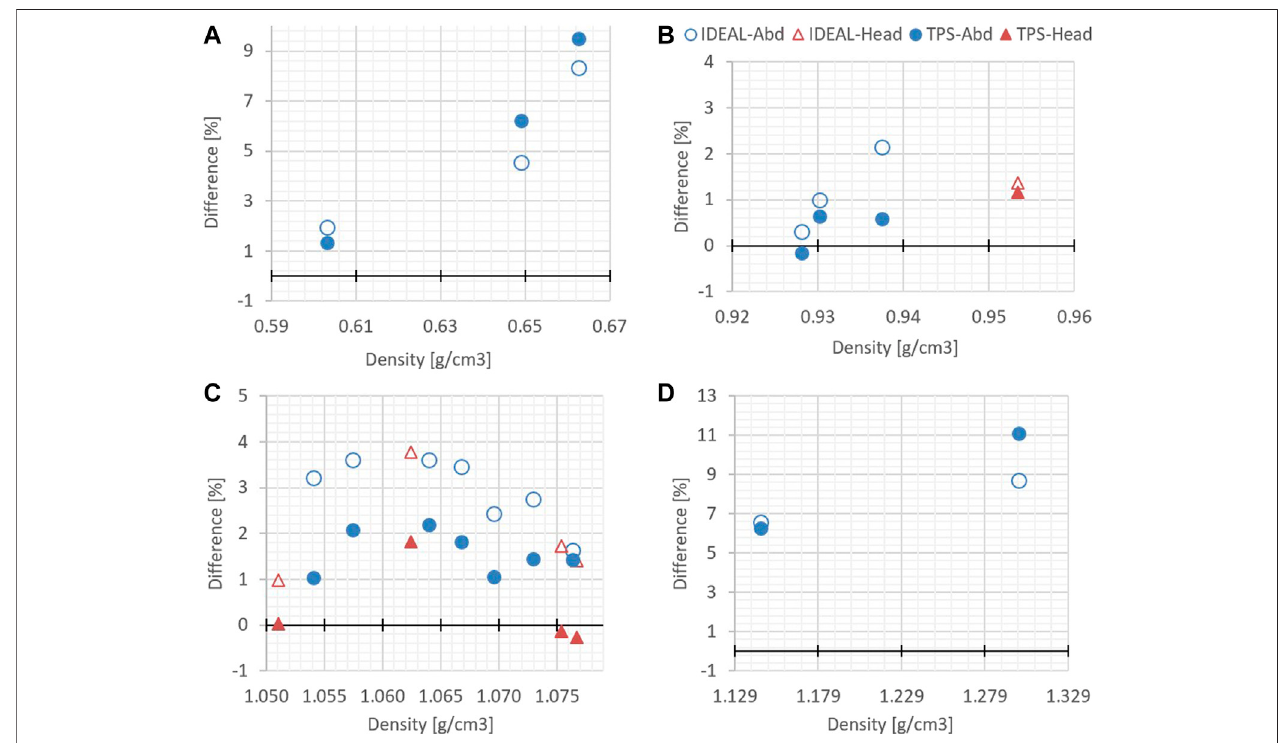
FIGURE4| DifferencesbetweensimulatedWET(TPSandGATE-RTion/IDEAL)andmeasuredWET,asafunctionofthetissuedensity. (A) correspondstothelung region, (B) and (C) to the soft tissues regions and (D) to the bone region.